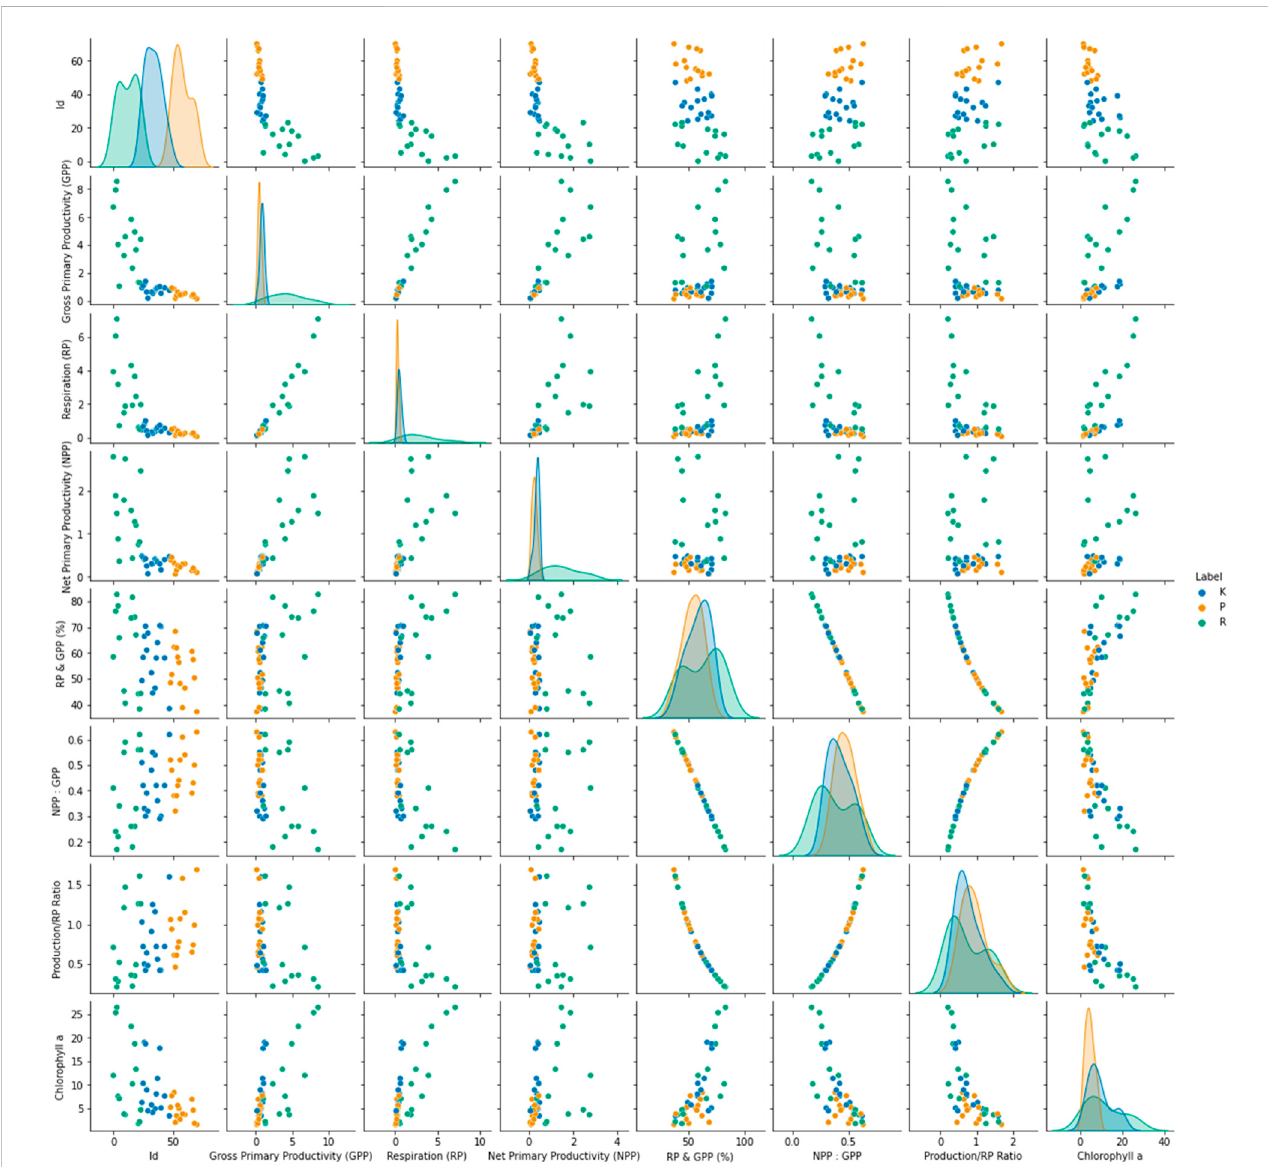
FIGURE 4 Productivity analysisofthree lakesintheWesternHimalayan region:Rewalsar(R-Green),Kuntbhyog(K-Orange), andPrashar(P-blue) lakes.Thedataon gross primary productivity (GPP), respiration (RP), net primary productivity (NPP), chlorophyll a, and their respective proportions were plotted for the three lakes. The parametricspreadfor the three lakes indicated therelative similarity in Kand P lakes vis-à-vis R. The GPP of K and P wasverylow as comparedto R. The GPP of R demonstrated a very wide variation. Inclusion of the respiration parameter makes this difference more